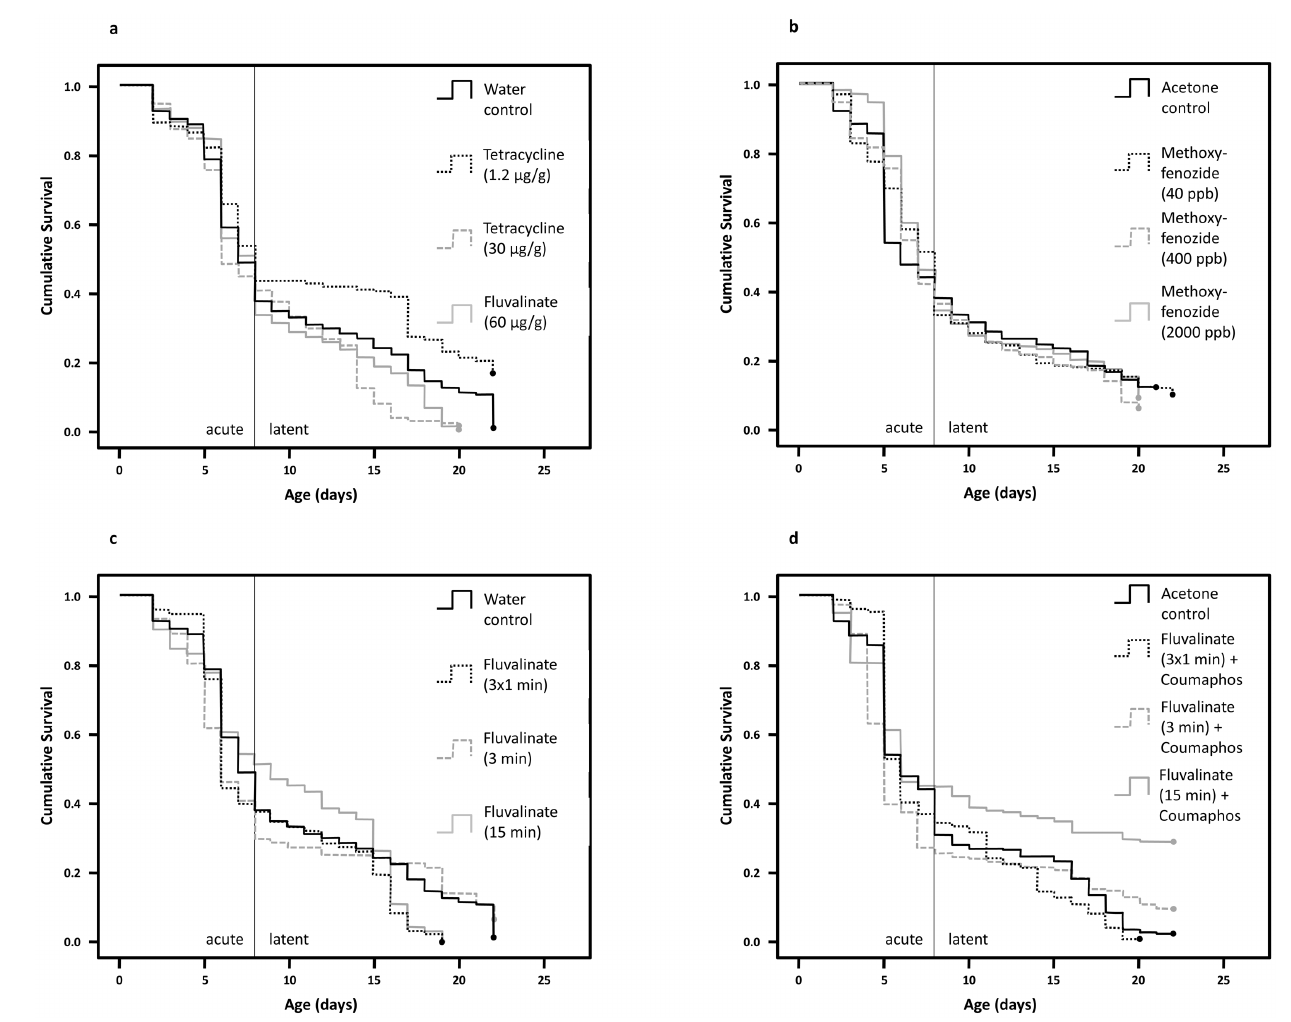
Figure 5. Survival of worker cohorts under high-density cage conditions was lower than in the initial screening experiment and varied inconsistently among treatments. Different panels summarize cumulative survival of honey bee workers grouped from different cage replicates according to the tested xenobiotic: (a) tetracycline, (b) methoxyfenozide, (c) tau-fluvalinate, and (d) the combination of tau-fluvalinate and coumaphos. Acute mortality effects were measured during the first 7 days of exposure, while legacy mortality effects were measured on the days after treatment had ended.